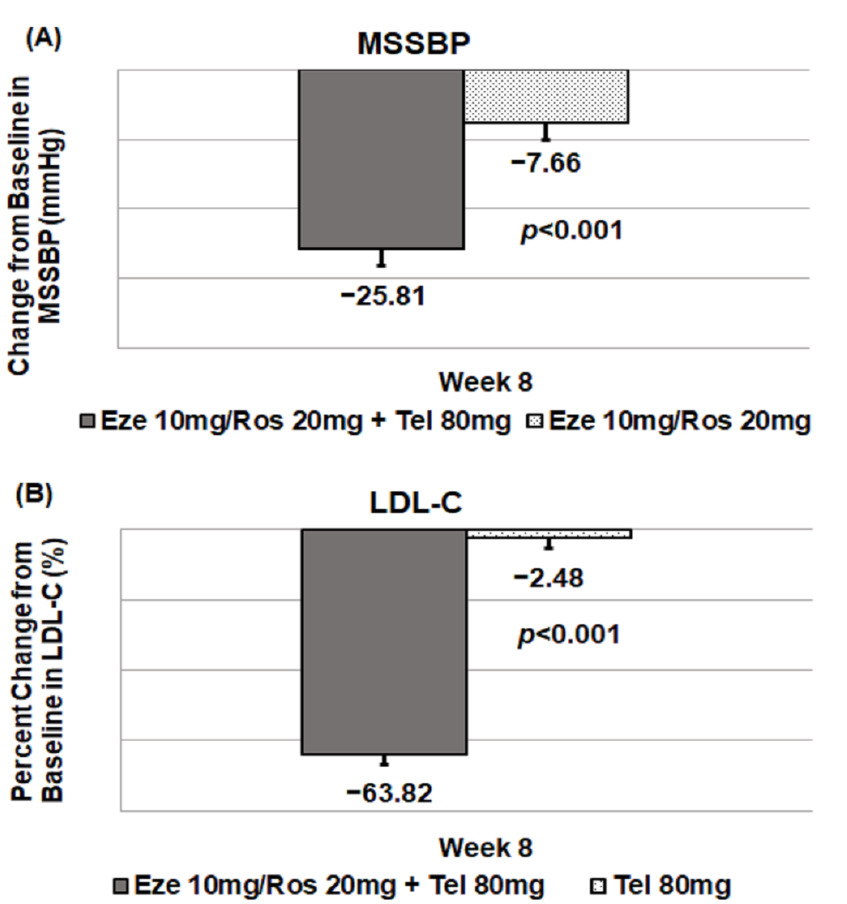
Figure 2. Primary outcomes: change from baseline in MSSBP and LDL-C at week 8. ( A ) MSSBP, ( B ) LDL-C.